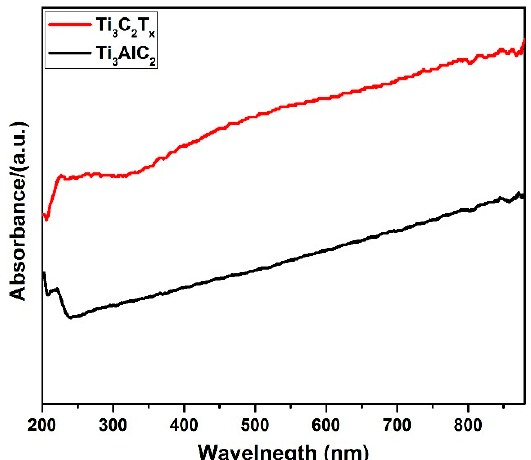
Figure 3. UV-Vis spectra of Ti 3 AlC 2 MAX precursor and Ti 3 C 2 T x Mxene.